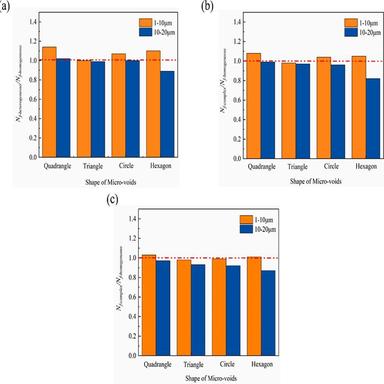
Fretting fatigue lifetime ratios for different shapes of micro-voids: (a) Test No. 2, (b) Test No. 3 and (c) Test No. 4.